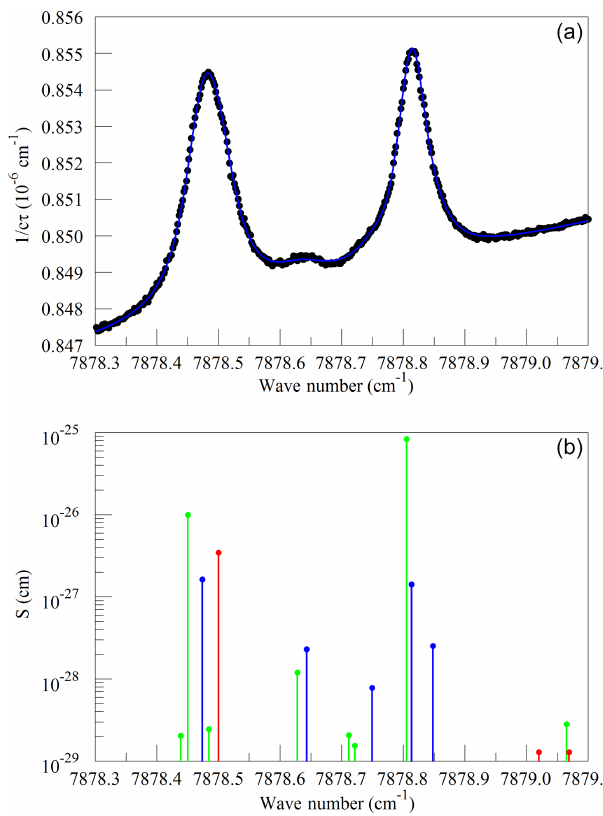
Figure 5. (a) Spectrum of water in nitrogen (points) and fit to the Voigt model (blue curve). (b) Oxygen (green), normal water (blue), and deuterated water (red) lines in the 2016 HITRAN